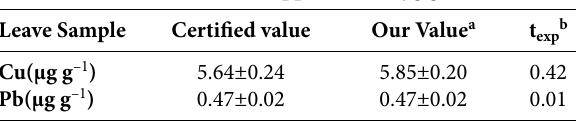
table 6. Analytical results of Pb(II) anb Cu(II) determination in Certified Reference Material of Spiked Natural Leave Samples with the proposed method (n =